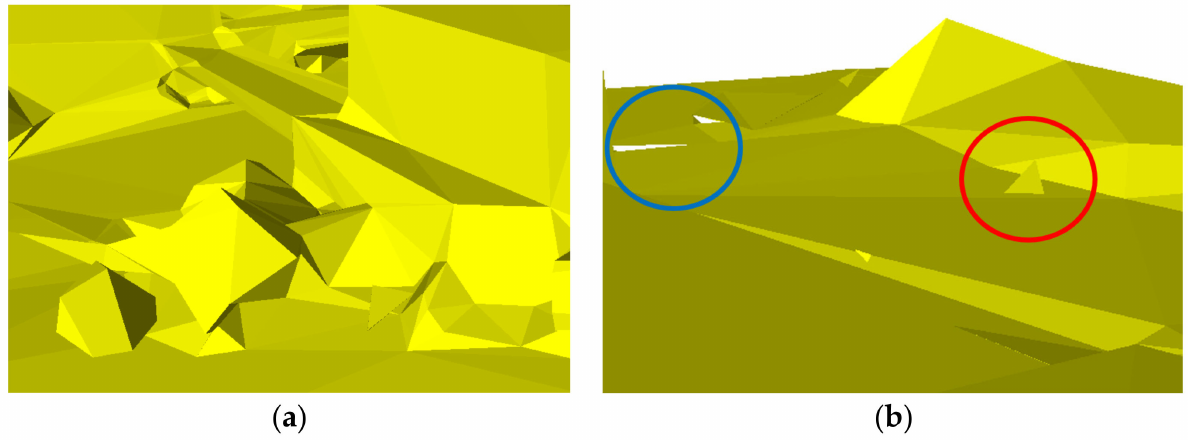
Figure 10. The problem of VSA result. ( a ), substantial retention of non-architectural details; ( b ), topology problem. There are two holes in the blue circle and a dangling facet in the red